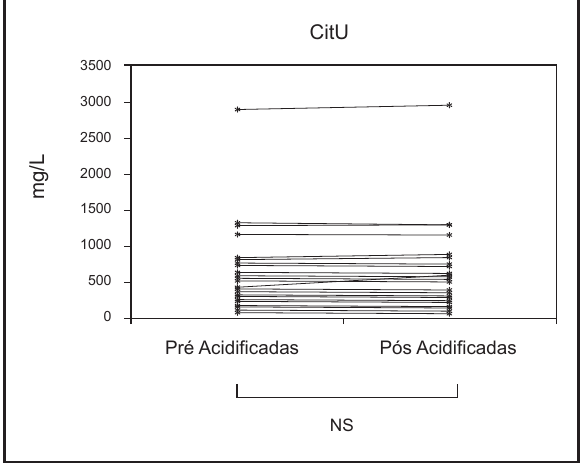
Figura 3 – Valores individuais do CitU na presença de timol em amostras isoladas de urina com adição de conservante ácido imediatamente ou 24 horas após a coleta CitU: Citrato